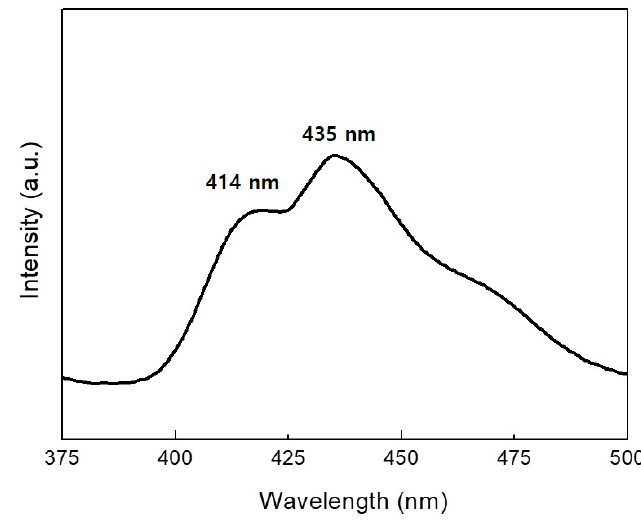
Figure 6. Room temperature (RT) photoluminescence (PL) spectrum of the a -Si nanotips obtained under excitation at 266 nm.